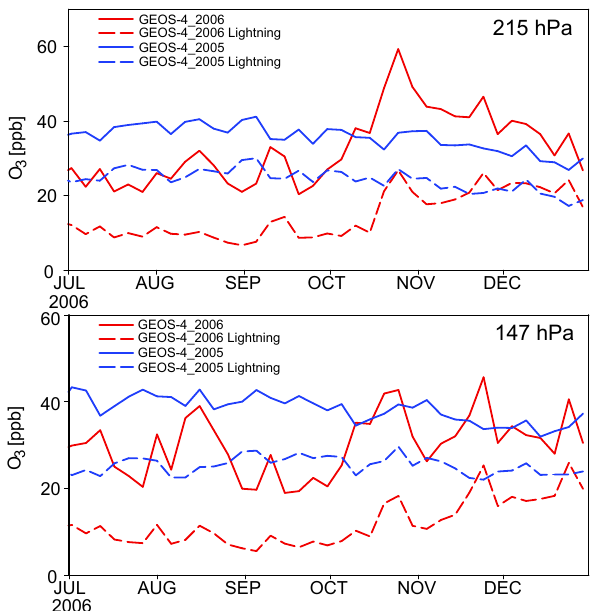
Fig. 15. GEOS-Chem simulated relative contributions to upper tro- pospheric O 3 over the WCI domain from July to December 2006: biomass burning (blue line), lightning (yellow line), soil (grey line), biofuel (green line), and anthropogenic activities (red line). Also shown are total O 3 from the standard simulation (black line). Val- ues are 5-day